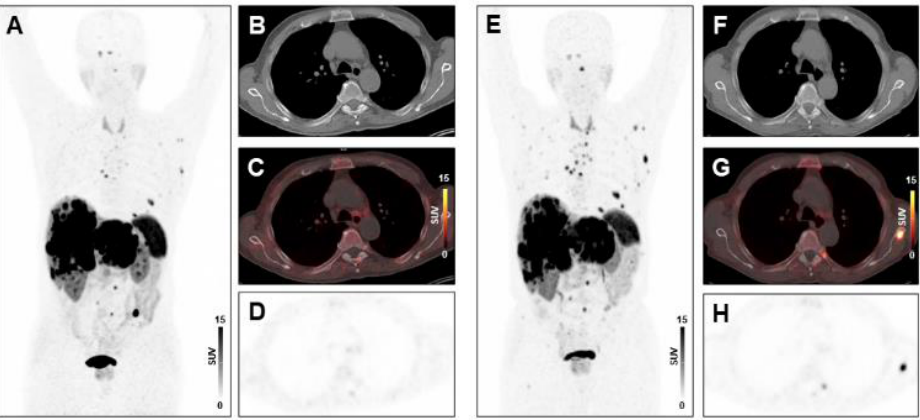
Figure 3. Absence of treatment response to PRRT in a patient with high systemic inflammation at baseline. MIP image ( A ) and transversal PET/CT images ( B – D ) of baseline [ 68 Ga]Ga-DOTA-TATE-PET/CT showing osseous and hepatic metastases in a 76-years-old male GEP-NET patient. MIP image ( E ) and transversal PET/CT images ( F – H ) at follow-up after two cycles of PRRT demonstrating progression with new osseous lesions (SSR-TV decreased mildly from 797.26 cm 3 to 734.09 cm 3 , however new lesions appeared, consistent with progressive disease). The baseline CRP level was 31.2 mg/L, the PCM was 14,196, and the HSPI 1, evidencing high systemic inflammation.